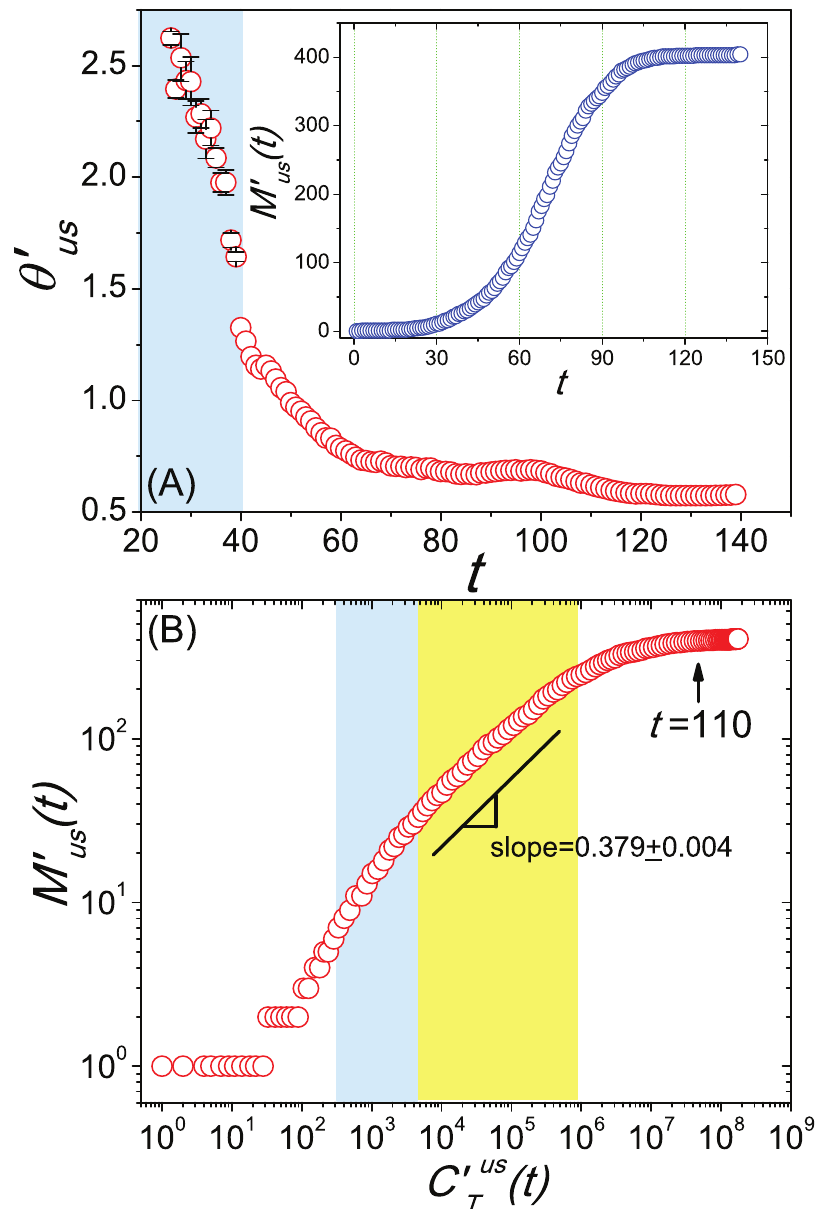
Figure 4. The statistical results of the scaling properties of our metapopulation model. (A) Temporal evolution of the estimated exponent h ’ us of the normalized distribution P ’ us ( r ) . The inset shows the growing of the number of infected subpopulations M ’ us ( t ) with time t . (B) The relation t between the number of infected subpopulations M ’ us ( t ) and the national cumulative confirmed cases C ’ us corresponds to their different evolution stages, respectively. Each data in these figures are the median results over all runs that led to an outbreak at the U.S. level in 100 random Monte Carlo realizations.